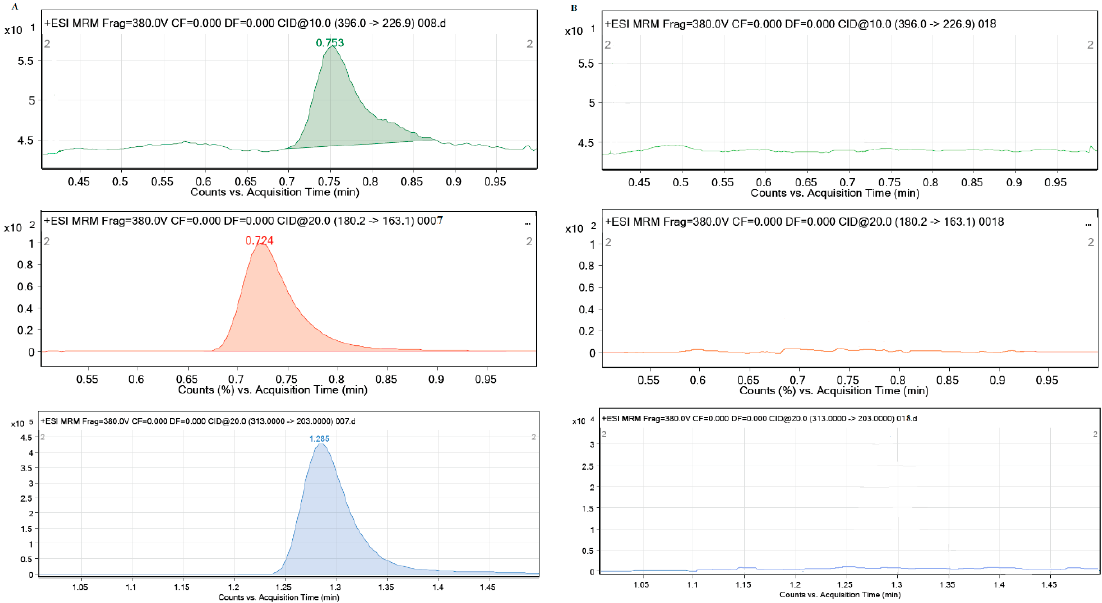
Figure 1. Characteristic MRM mass spectra of ( A ) standard solution of CEF: 396.0 → 226.9; MEM: 180.2 → 163.1; PRAZ: 313.0 → 203.0 and ( B ) investigated sediment matrix (Glina).